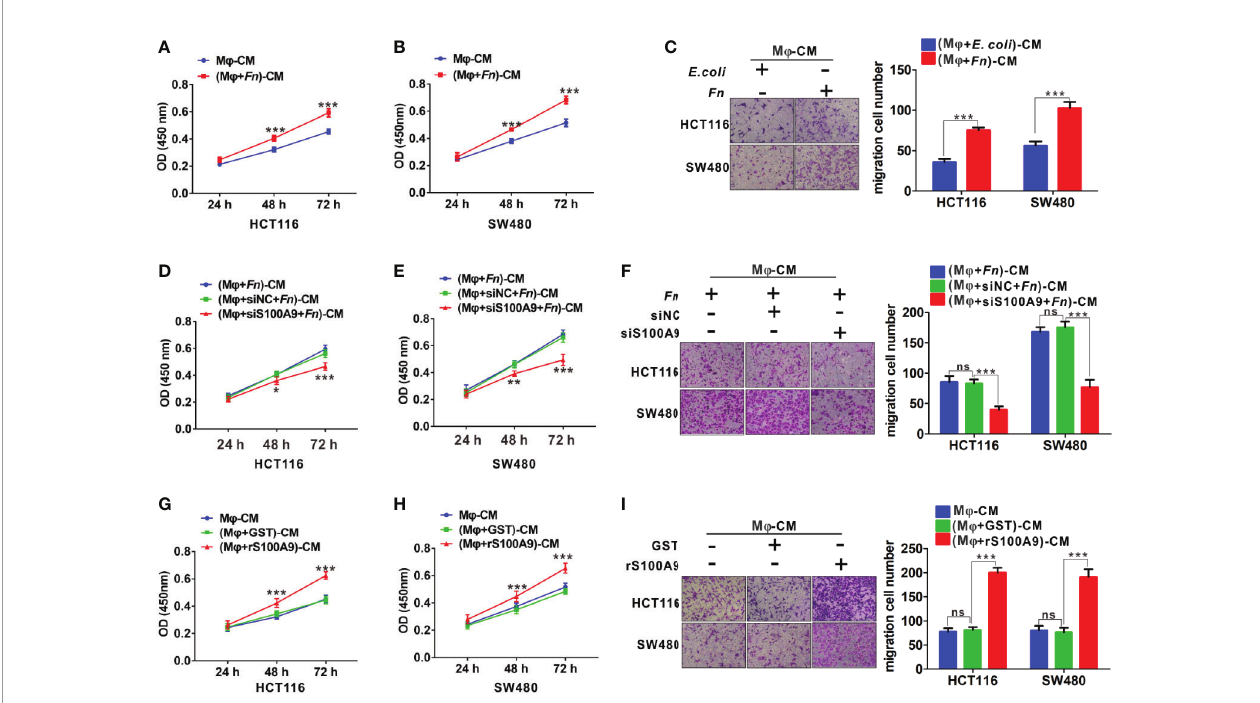
FIGURE 4 | Fn -challenged M2-M j , which was mediated byS100A9, promotes the proliferation andmigration of CRC cells. (A,B) CCK8assay was used to determine the proliferation ability of CRC cellsco-cultured with (M j + E.coli )-CMor (M j + Fn )-CM for 24, 48, and72 h. (C) Transwellassay was used to determine the migration ability of CRC cells co-cultured with (M j + E . coli )-CM or (M j + Fn )-CMfor 24 h. Magni fi cation, 100×. (D,E) CCK8assay was usedto determine the proliferation ability of CRC cells co-cultured with (M j + Fn )-CM,(M j + siNC + Fn )-CM,(M j + siS100A9 + Fn )-CM for 24, 48, and 72 h. (F) Transwellassay was used to determine the migration ability of CRC cells co-cultured with (M j + Fn )-CM, (M j + siNC + Fn )-CM,(M j + siS100A9 + Fn )-CM for 24 h.Magni fi cation,100×. (G, H) CCK8 assay was used to determine the proliferation ability of CRC cellsco-cultured with untreatedM j -CM,(M j + GST)-CM and(M j + rS100A9)-CM for 24, 48, and72 h. (I) Transwellassay was used to determine the migration ability of CRC cells co-culturedwith untreated M j -CM,(M j + GST)-CM and(M j + rS100A9)-CMfor 24 h.Magni fi cation,100×.In (A,B, D, E,G,H) , data shown are mean absorbances ± SD. In (C,F, I) , data shown are mean migrating cells± SD. ns, not signi fi cant. *p< 0.05, **p < 0.01, ***p <